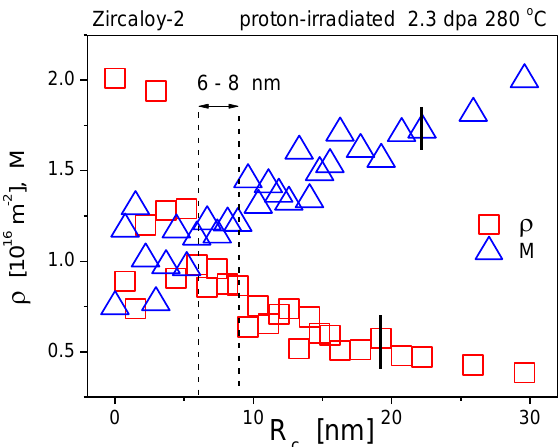
Figure 7. Systematic analysis of the effect of value of R c in the CMWP procedure. The dislocation density, ρ , and the dipole character parameter, M , vs. R c in the range of 0 ≤ R c ≤ 30. The vertical black lines indicate the error margin.